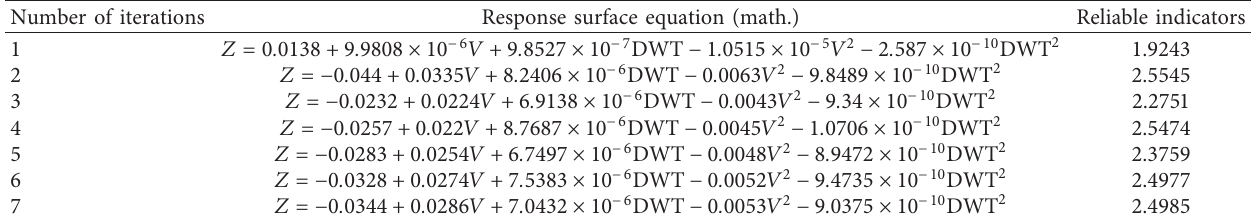
Table 9: Iterative process of ship crash reliability at bridge formation.